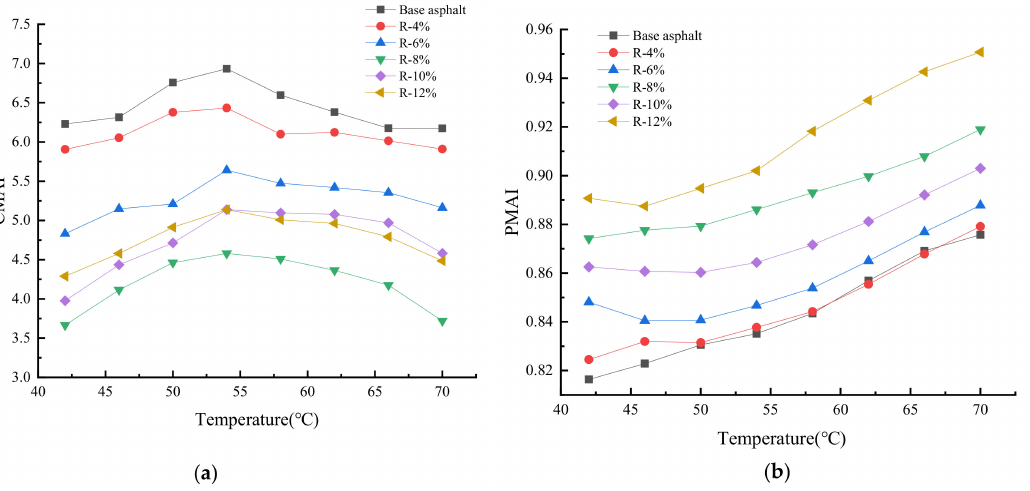
Figure 9. Thermo-oxidative aging resistance of reclaimed asphalt after PAV aging. ( a ) CMAI. ( b )